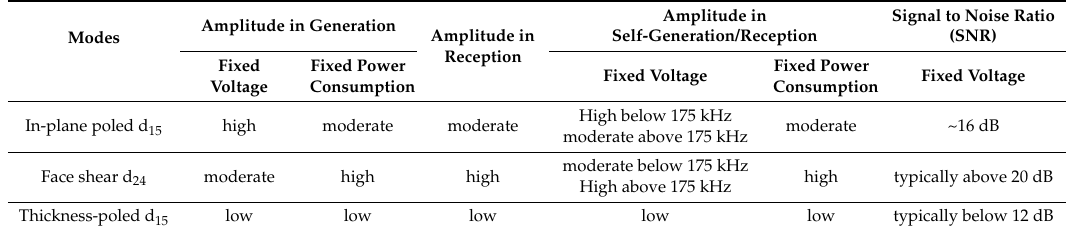
Table 1. The performances of different shear mode piezoelectric wafers in SH 0 wave generation and